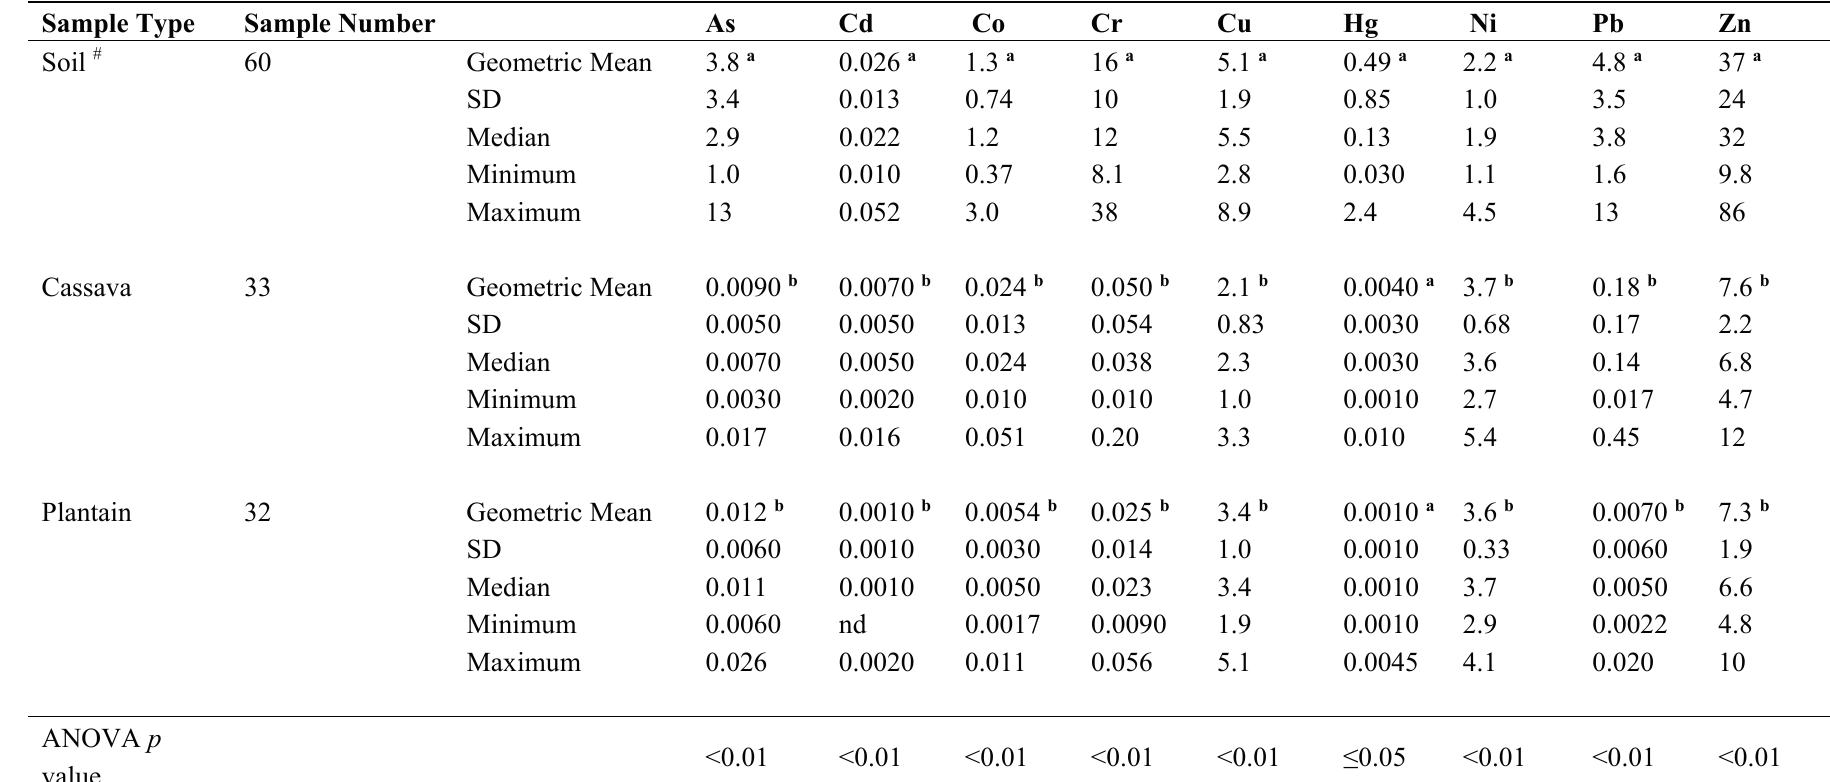
Table 1. Concentrations (geometric mean, SD, minimum, maximum) of heavy metals and metalloid in soil (mg/kg dw) and foodstuffs (mg/kg ww) in